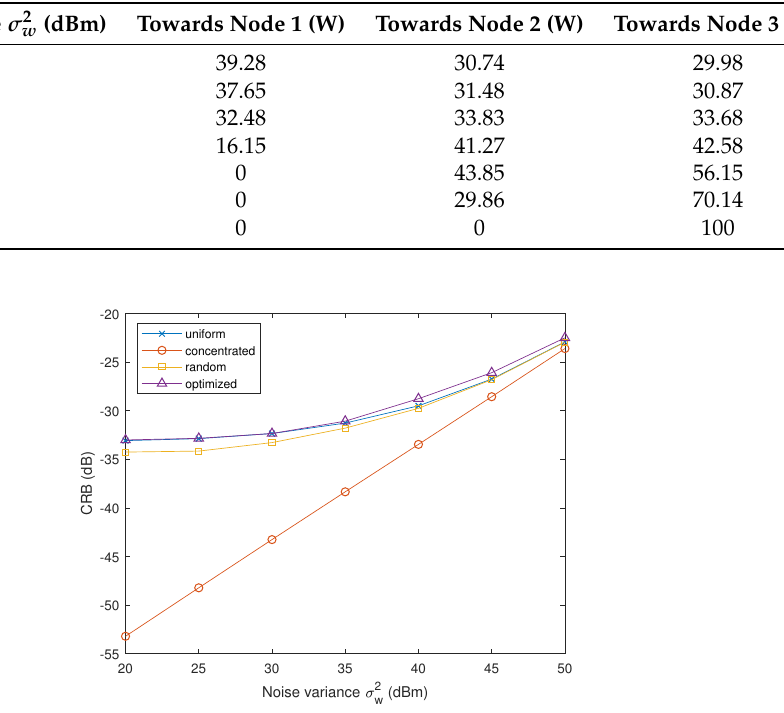
Figure 3. CRB of v x versus the noise variance of radar receiver in the first experiment of Scenario